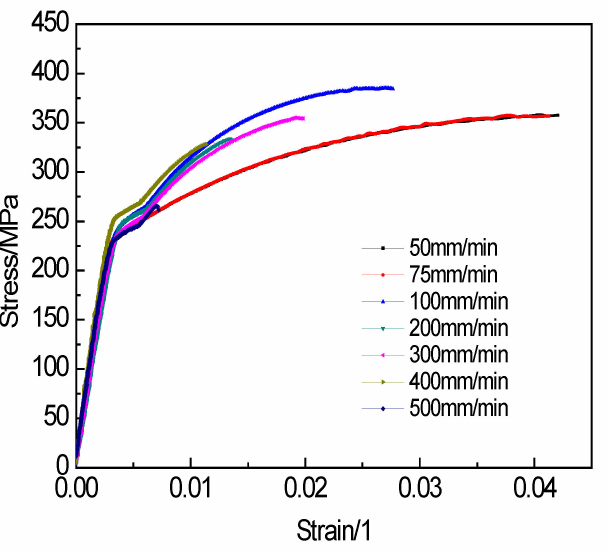
Figure 4. Strain − stress curves of robotic FSW 2198 Al − Li alloys